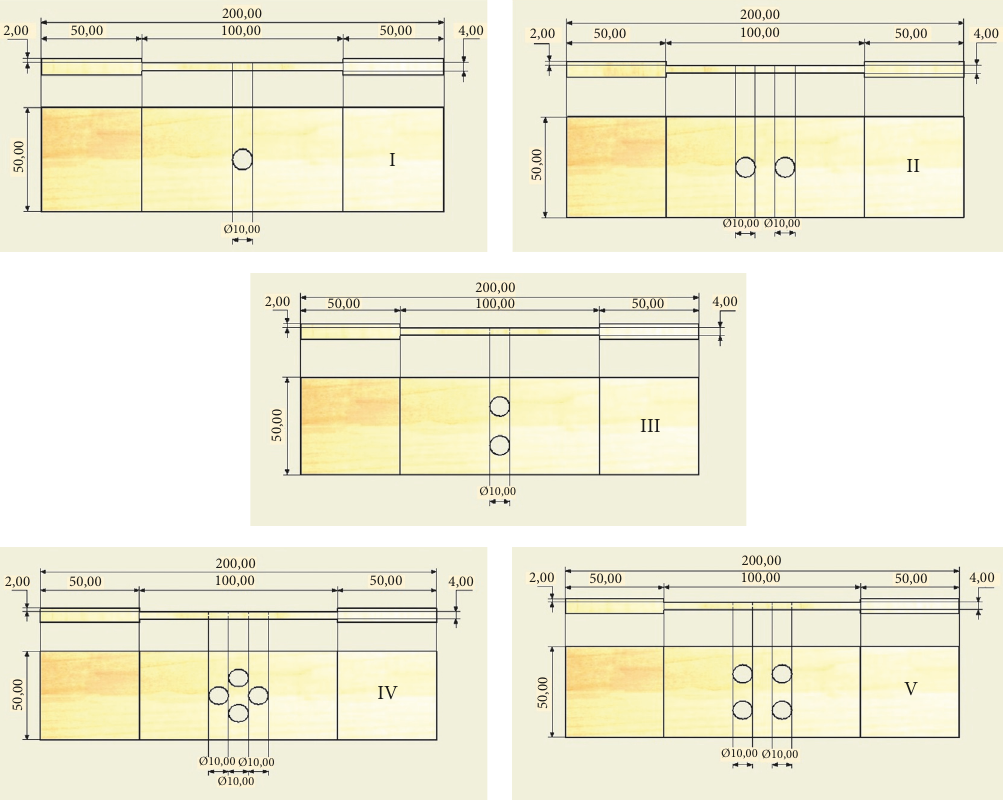
Figure 2: Specimen geometry (all dimensions in mm).